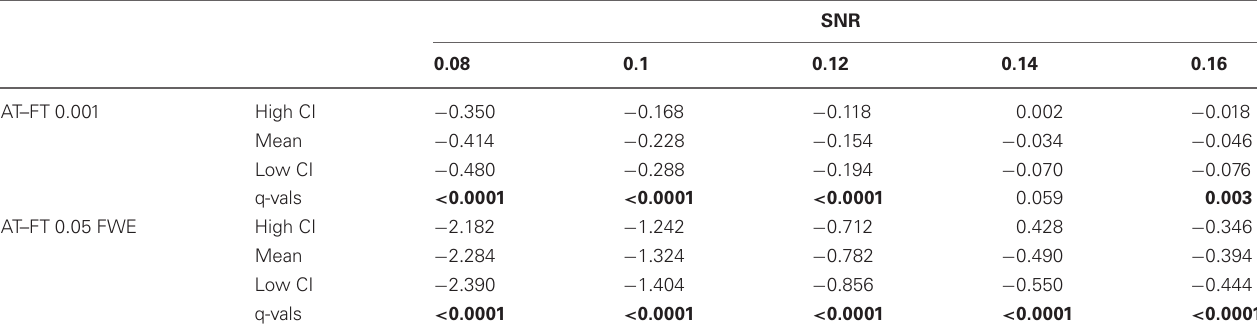
Table 1 | Statistical analysis the pair-wise difference (AT-FT) comparison of cluster error trade-off.